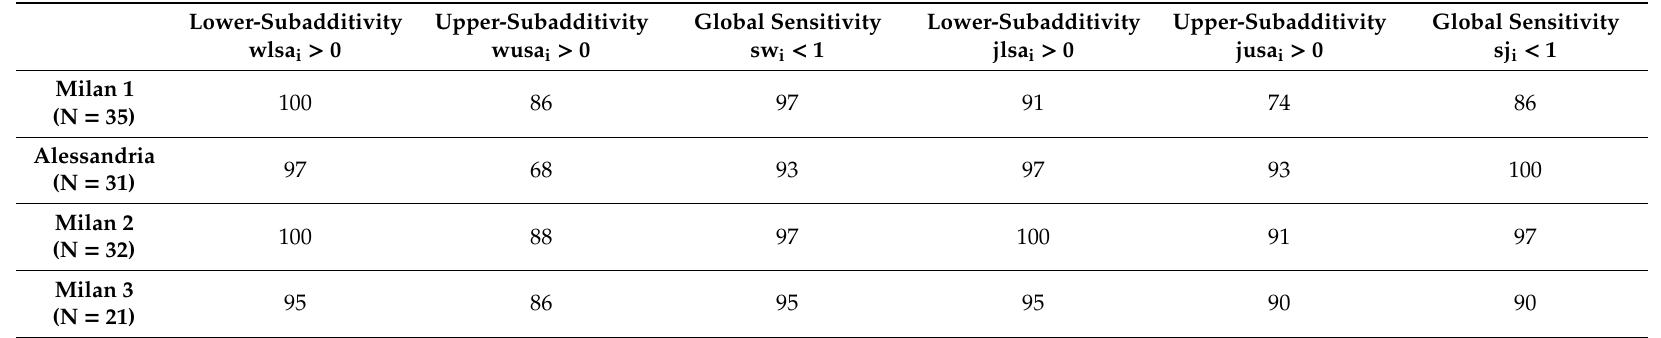
Table A5. Percentage of subjects satisfying bounded subadditivity (BA) at median individual